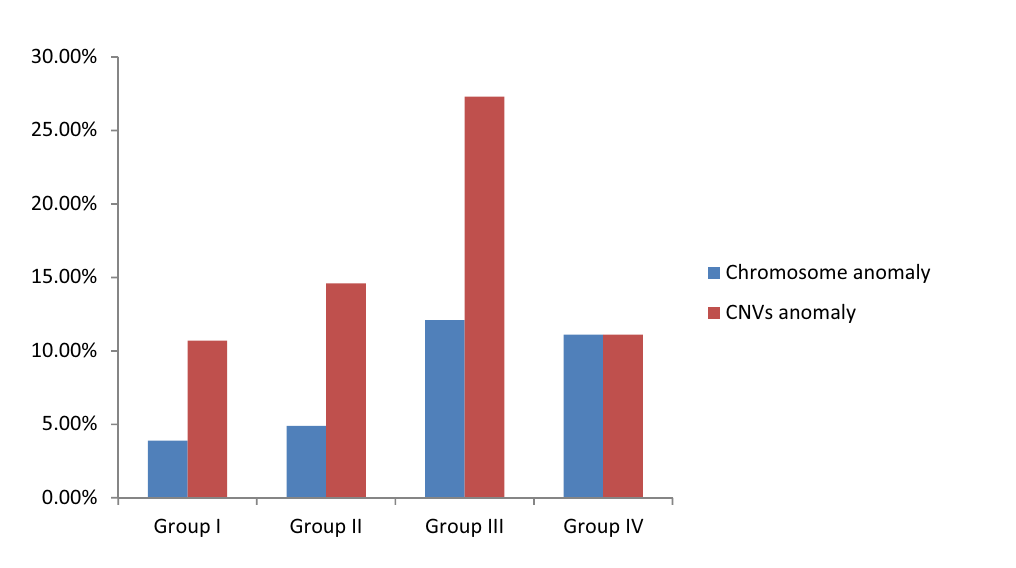
Figure 2. The chromosome and CNVs anomaly among four